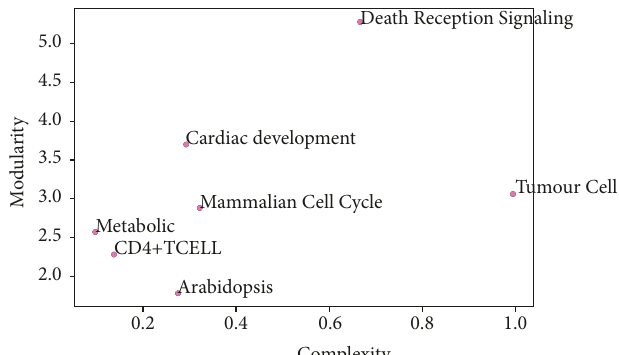
Figure 13: Complexity versus modularity for seven biological